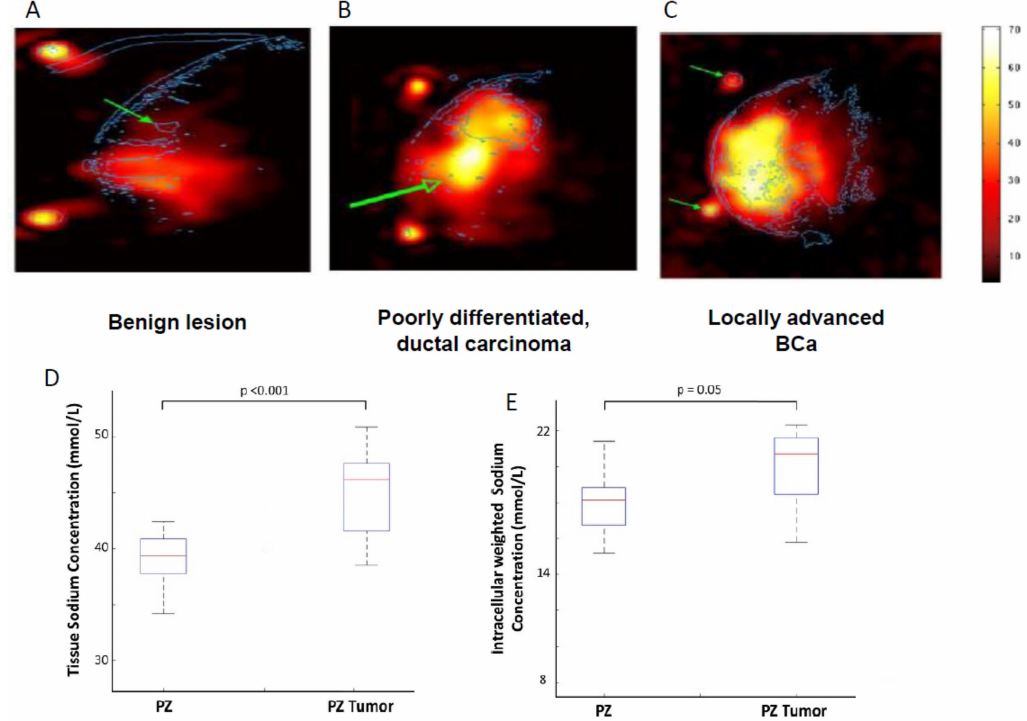
Figure 4. Clinical measurement of tissue sodium levels in breast cancer (BCa) and prostate cancer (PCa) with magnetic resonance imagining (MRI). ( A – C ) 23 Na-MRI’s from three di ff erent BCa patients. ( A ) A benign lesion (proliferative fibrocystosis), indicated by the arrow, aligned from gadolinium-enhanced image. ( B ) Infiltrating poorly di ff erentiated ductal carcinoma (outlined in blue). Below (indicated by the green arrow) is a region with edema. ( C ) A large locally advanced BCa (outline in blue). The arrows indicate positioning landmarks. The intensity scale on the far right indicates approximate sodium concentrations (relative). Modified from [66]. ( D , E ) Magnetic resonance spectroscopic imaging (MRSI) of prostate. ( D ) Box plots of the tissue sodium concentration in normal and PCa tissue in peripheral zone (PZ) showing significantly increased sodium level in the latter. ( E ) Same as ( D ), but showing intracellular-weighted sodium concentration. Modified from